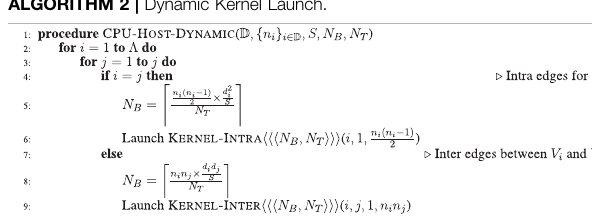
ALGORITHM 2 | Dynamic Kernel